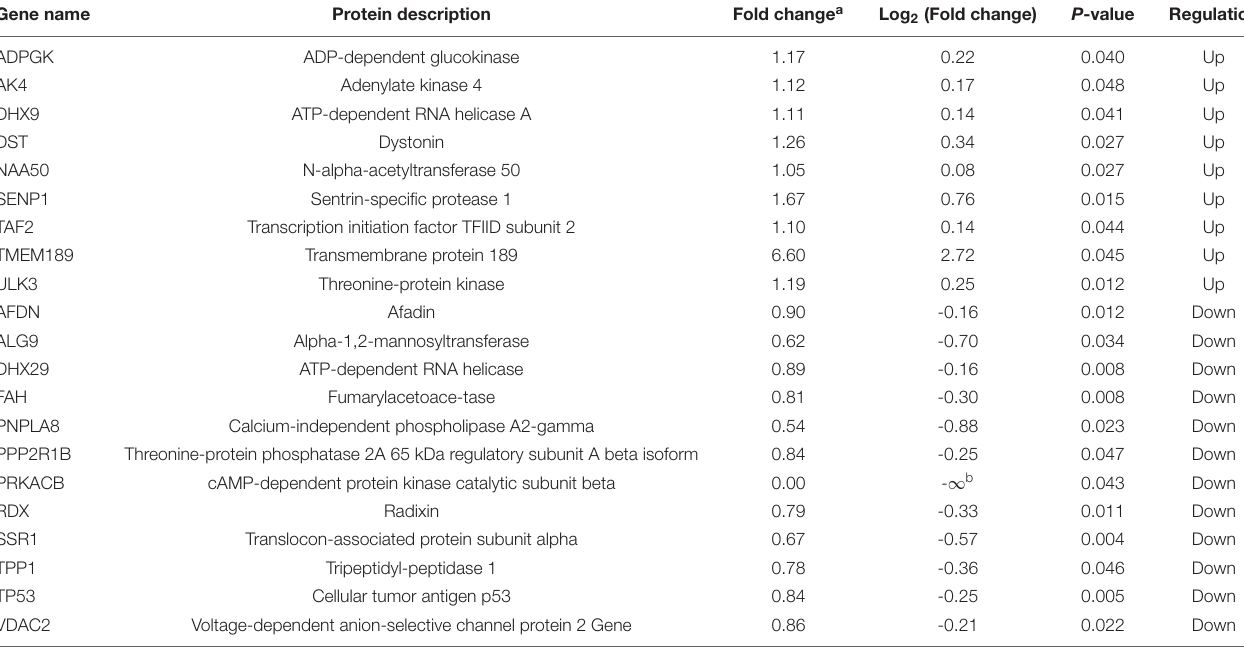
TABLE 2 | Protein expressions of predicted target genes were upregulated or downregulated after the transfection of sRNA71